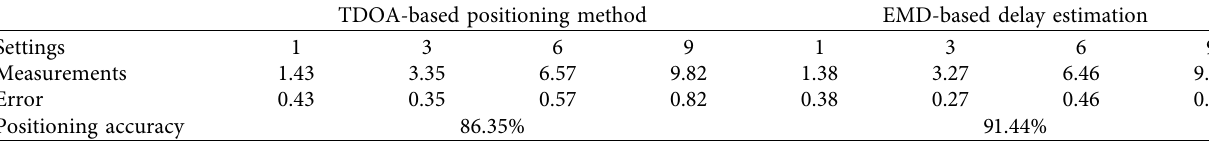
Table 1: Target localization results when the sensor distance is 1m.